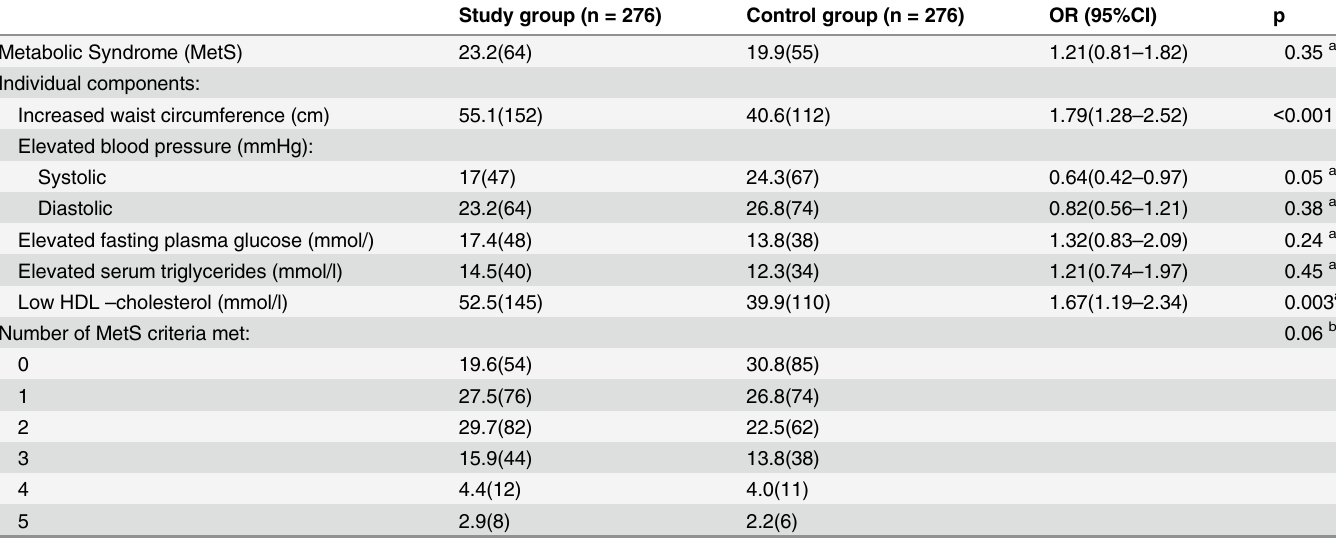
Table 3. Prevalence of the individual components of metabolic syndrome in the study and control